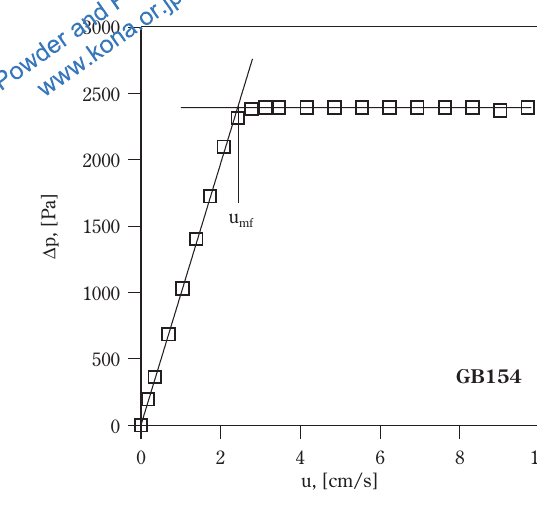
Fig. 1 Fluidization of a monodisperse particle bed.